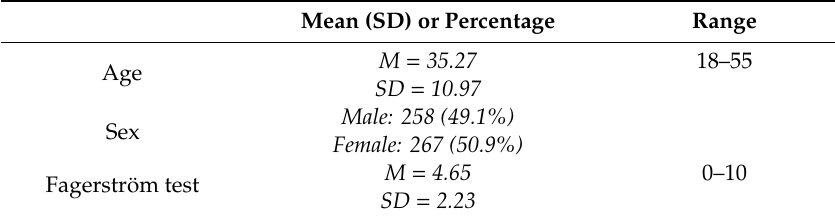
Table 1. Characteristics of the study participants ( n =